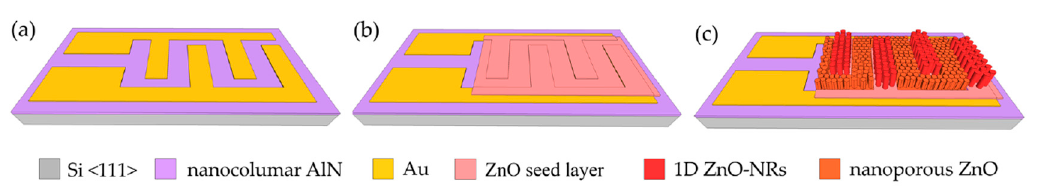
Figure 1. Sensor fabrication process steps: ( a ) deposition of Au layer; ( b ) ZnO seed layer deposition; ( c ) growth of ZnO nanorods and